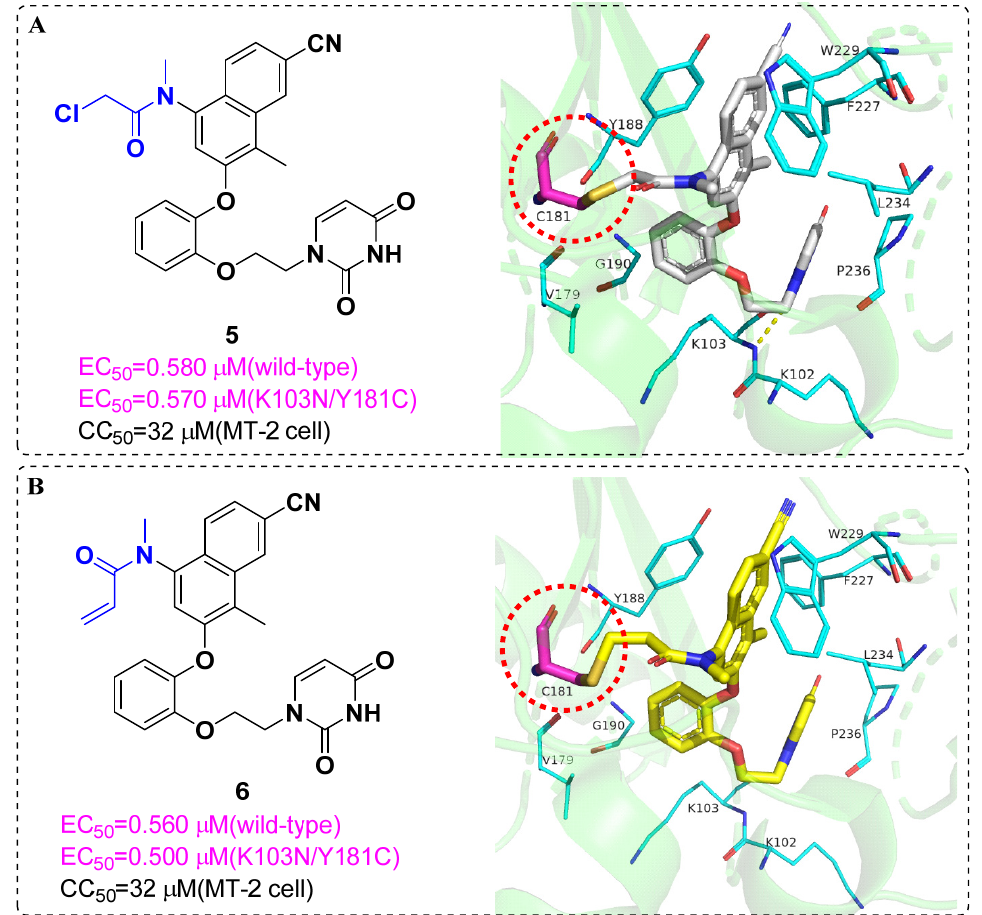
Figure 4. ( A ) Chemical structure of 5 and crystal structures of Y181C RT in complex with 5 (PDB code: 5VQX); 5 forms a covalent bond with the sulfhydryl group of Cys181. ( B ) The same as A but with Y181C: 6 (PDB code: 5VQV) [24]. The figures were generated by PyMol.